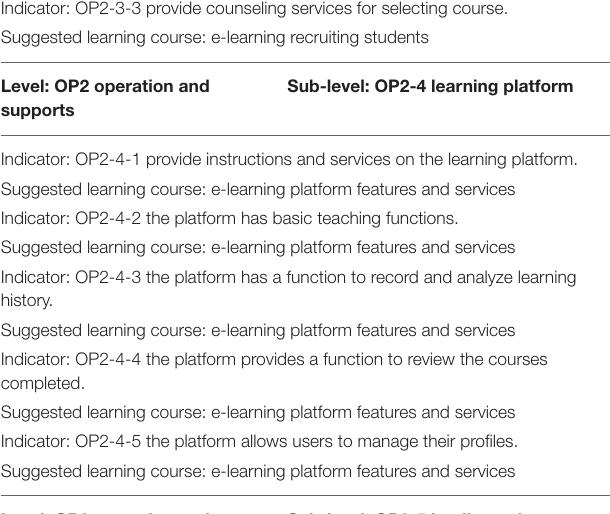
TABLE 4 | Organization – Execution and Implementation Content. Level: OP1